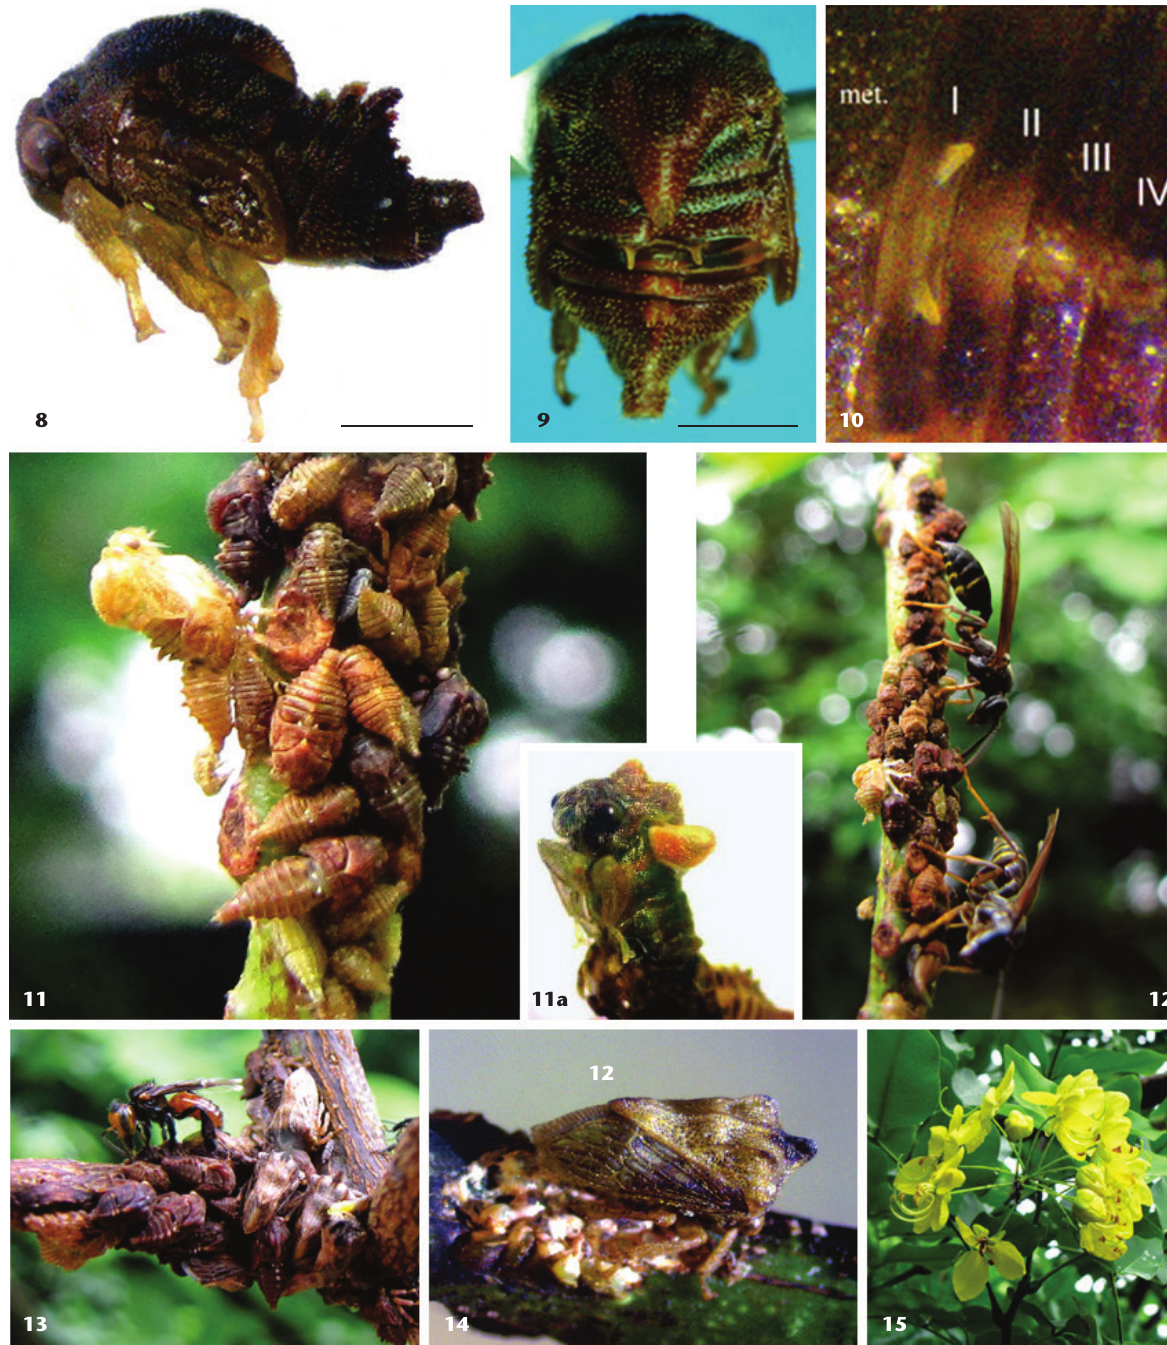
5Figures 8-15. Talipes appendiculatus , associated insects and host plant. Nymphs: 8-9, 5 th instar in lateral and dorsal view; 10, details of the abdominal terga I-IV, showing the finger-like projections on tergum I; 11, nymphs in different stages, one of them in process of ecdysis; 11a, emergence of an adult (female). Hymenoptera: 12-13, bee Oxytrigona tataira (Smith) (Apidae-Meliponini) and wasps (Vespidae) collecting honey dew. Posture: 14, female on the egg mass. Host plant: 15, flowered branch of Cassia fistula L. (Leguminosae, Caesal- pinioidea). Scale bars: 1.0 ZOOLOGIA 33(6): e20160103 | DOI: 10.1590/S1984-4689zool-20160103 | December 15, 20164 /